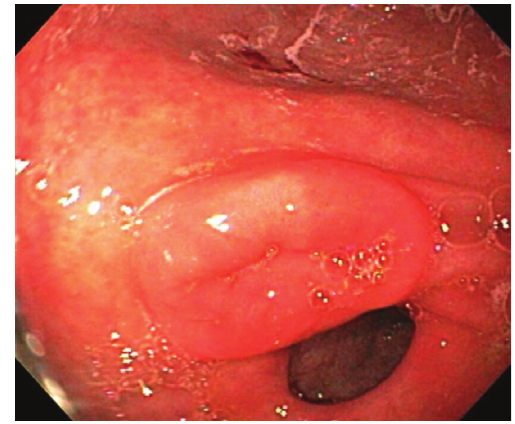
Figure 1: Umbilicated mass at the